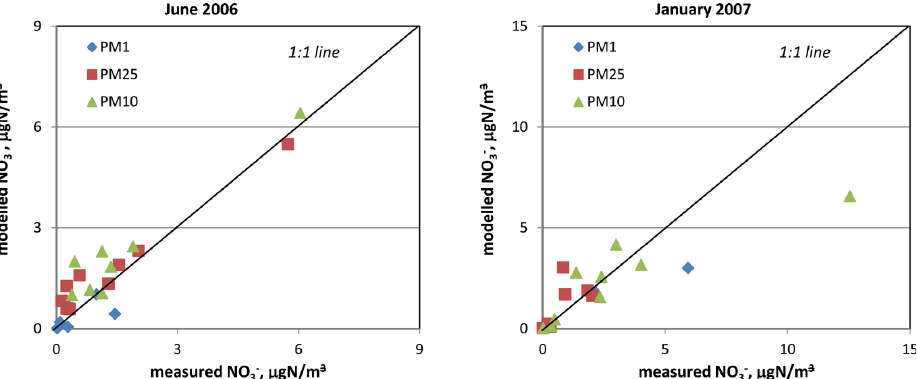
Fig. 9. Modelled and measured nitrate in the different size fractions for June 2006 (left) and January 2007 (right). Note different scale for the two